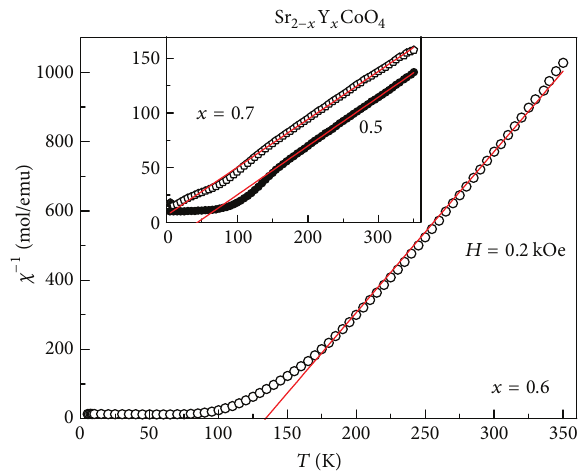
Figure 2: The temperature dependence of inverse of susceptibility ( 𝜒 −1 ) for Sr 1.4 Y 0.6 CoO 4 (the main frame) and Sr 2−𝑥 Y 𝑥 CoO 4 , 𝑥 = 0.50 and 0.70 (the inset). The red solid lines represent a fit according to Curie-Weiss